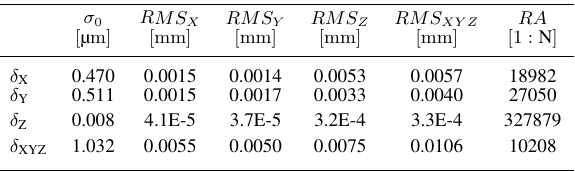
Table 1. Results of simulated data sets with different dome center shifts of each 5mm , optimized with the Brown model including all distortion parameters. RA is the relative accuracy, referring to the ratio of the maximum object dimension of 106 . 4mm and the RMS XY Z value.